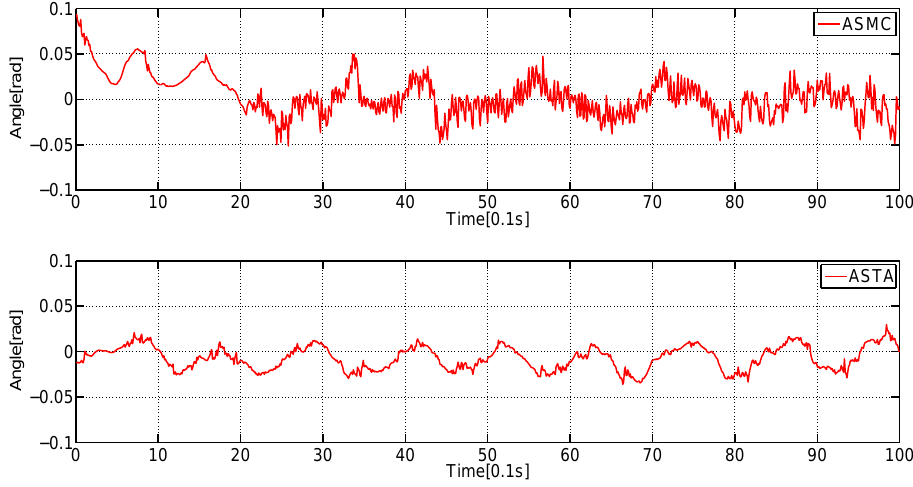
Figure 8. Comparison of the angles in Case